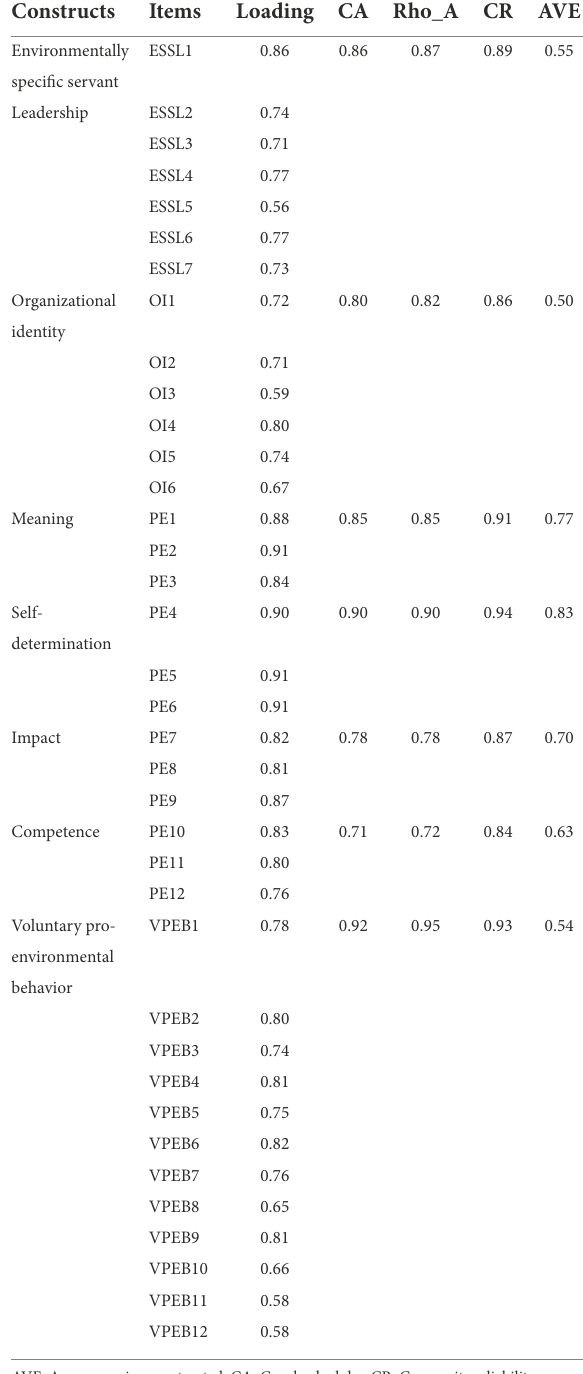
TABLE 1 Convergent validity and internal